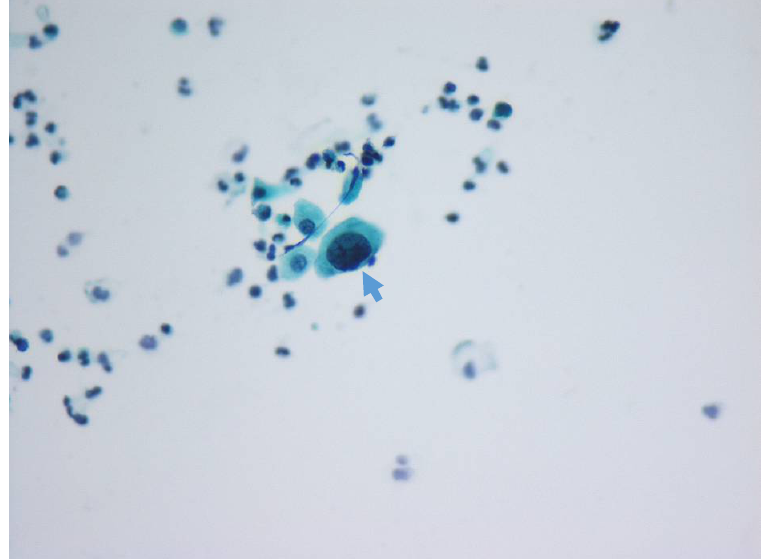
Figure 1. 100× image provided in the survey, which includes the target cell and adjacent cells with more background information for participants (arrow: representative cell, which would be demonstrated in another 400× image separately). Table 4. Survey Form (translated) *.